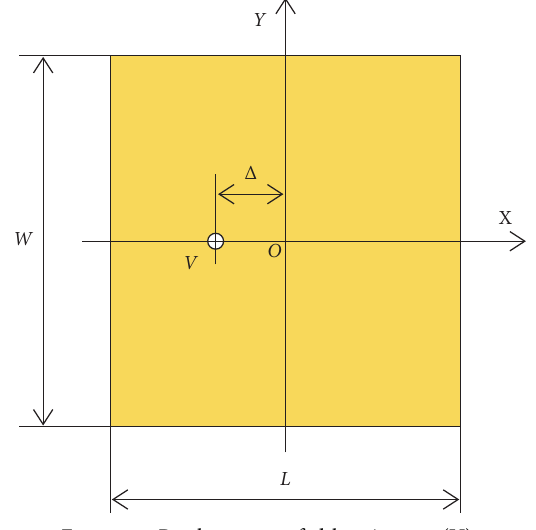
Figure 5: Patch antenna fed by via-port (V).